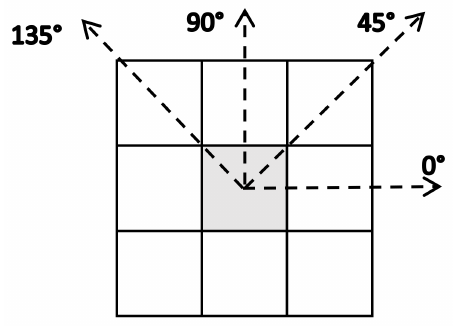
Figure 3. 8- connected Neighbours pixels Grey Level Co-occurrence